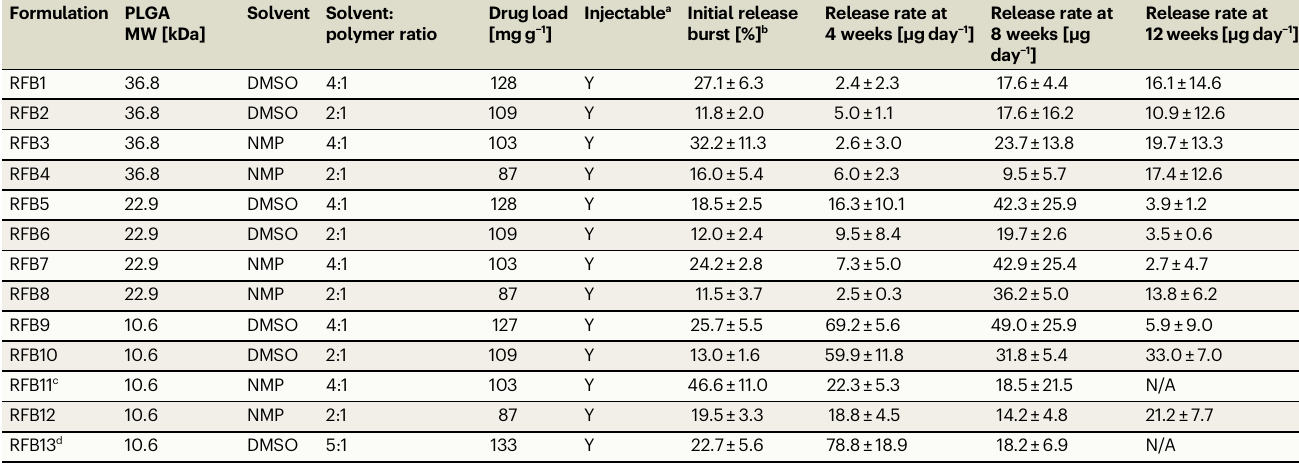
Table 1 | In vitro characteristics of LA-RFB formulations Formulation PLGA Solvent Solvent: MW [kDa] polymer